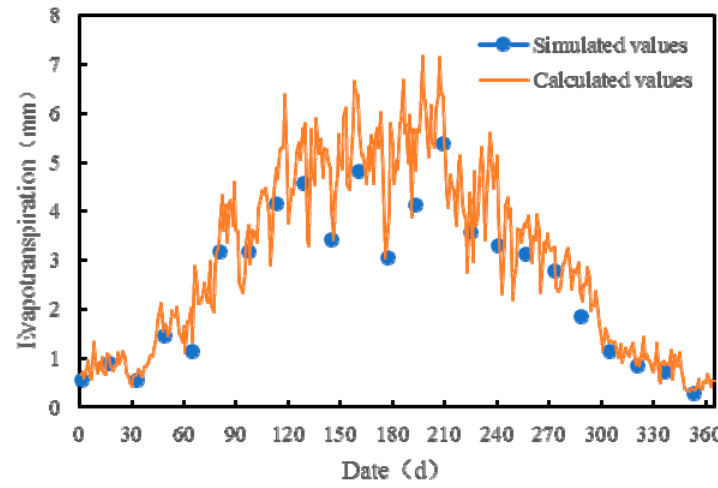
Figure 2. Simulated and calculated daily evapotranspiration at Hotan station in 2015.